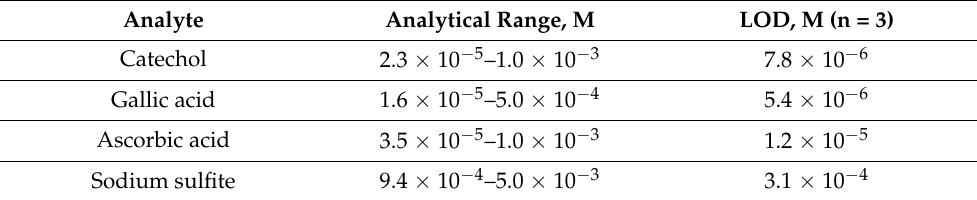
Table 3. Analytical parameters of antioxidants determination using SiTi12.5Fe/Phen.